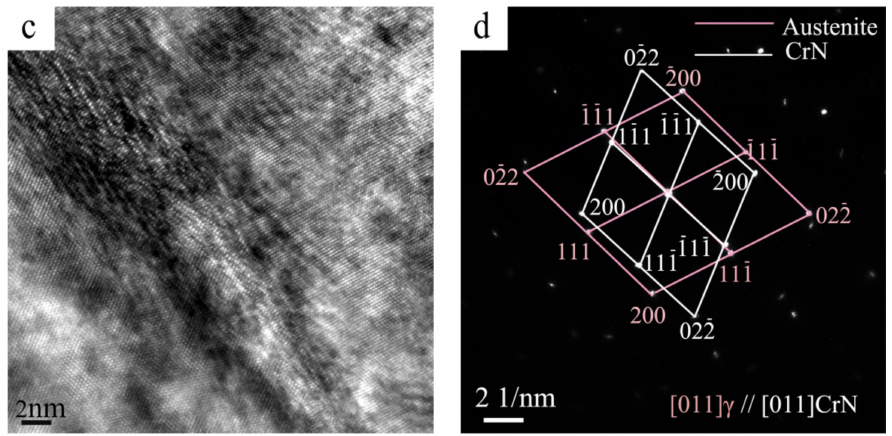
Figure 6. ( a ) TEM micrograph of the worm-shaped precipitate in N1120-30-374 alloy; ( b ) The corresponding SAED patterns of the worm-shaped precipitate; ( c ) HRTEM of interface between the worm-shaped CrN phase and γ ; and ( d ) corresponding FFT patterns of Figure